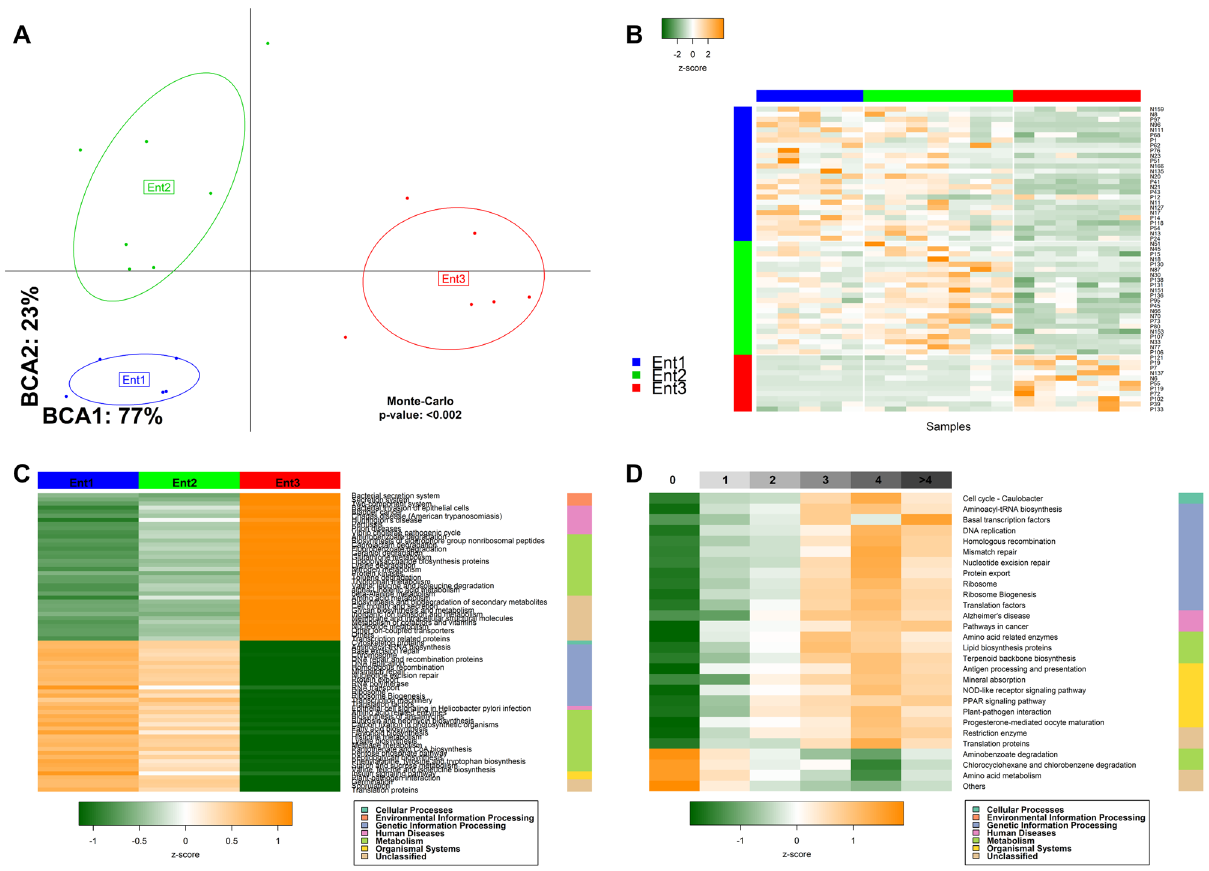
Figure 4. Metabolomic specificities of the microbiome in Malagasy volunteers. Eighteen volunteers were selected according to their enterotypes affiliation (nEnt1 = 5, nEnt2 = 7, nEnt3 = 6) and analysed through metabolomic approach. ( A ) The inter-class analysis computed upon PCA data emphasizes the stratification of these metabolomes in three clusters, similarly to microbiome enterotypes distribution. ( B ) Metabolic peaks (n = 51) discriminating the Malagasy metabolomes according to enterotypes stratification. ( C ) Metabolic functions inferred from PICRUSt that pointed out the functional specificities associated with each enterotypes. Functions listed in the heatmap had a significantly different distribution between enterotypes (p ≤ 0.01) and were selected according to Kruskal Walis’s test followed by a post-hoc Dunn’s test assessing the intergroup (enterotypes) comparison. All tests were corrected for false discovery rate. ( D ) Functions differentially distributed among protozoan carrier types (0 to >